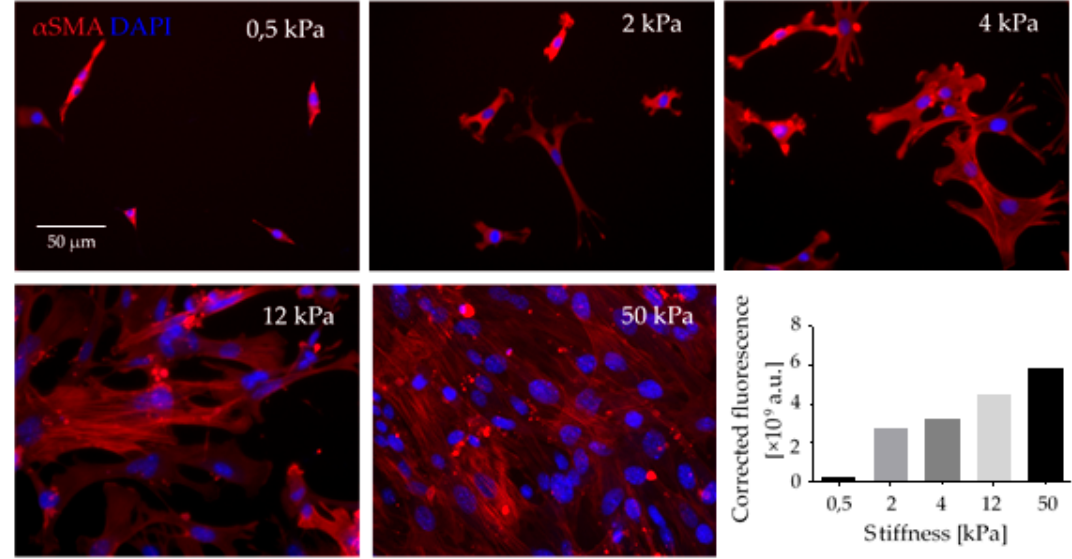
Figure 2. Mechanical stiffness of ECM is a crucial factor in CAF differentiation. Fibroblasts seeded in collagen-I coated polyacrylamide gels of defined stiffness (elastic modulus is given in kPa) exhibited increased adhesion and increased formation of α -Smooth muscle actin ( α SMA)-rich stress fibers (red fluorescence). α SMA immunostaining was quantified as total corrected fluorescence. This experiment reflects in vivo conditions, where the stiff scaffold of desmoplastic ECM contributes to CAF differentiation, together with soluble factors such as TGF β that are stored bound to ECM fibers and released when CAFs exert force on those fibers. Upon differentiation, CAFs change their morphology and express different biomarkers, such as α SMA stress fibers (red fluorescence). CAFs proliferate at higher rate, exhibit a secretory phenotype and enhanced contractibility; thus, they play an essential role in forming the TME. Scale Bar = 50 μ m.